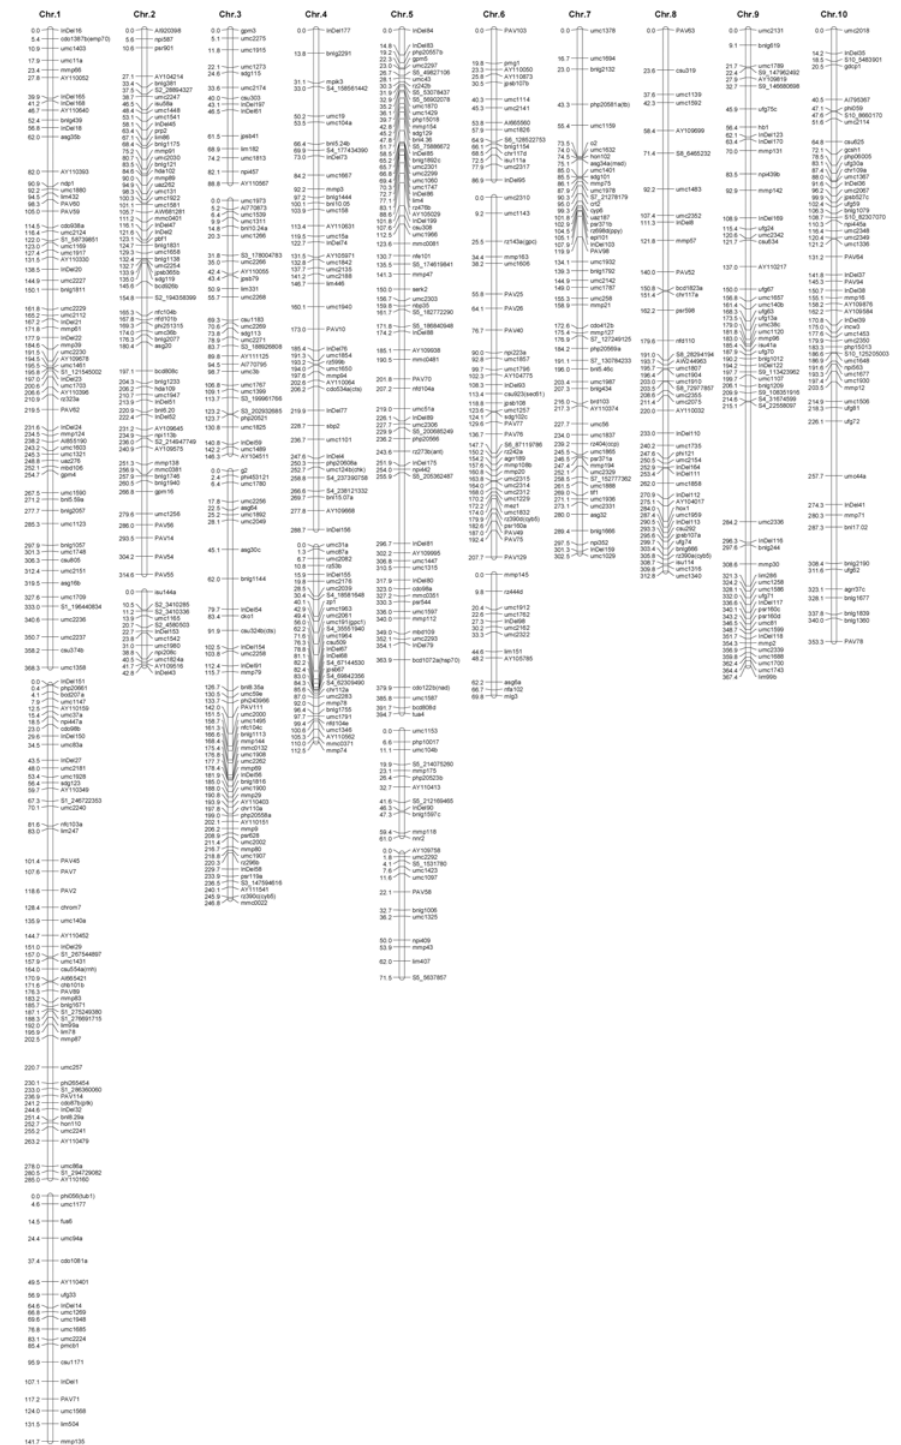
Fig 1. Linkage map generated from 302 individuals. Each chromosome is comprised of one or more LGs and each LG is represented by one bar. The bars of each chromosome were aligned vertically and not according to the order of chromosome framework. The numbers on the left of the bar represent the genetic position of markers as evaluated by the distance function of Kosambi in cM. The names on the right side of the bar indicate the